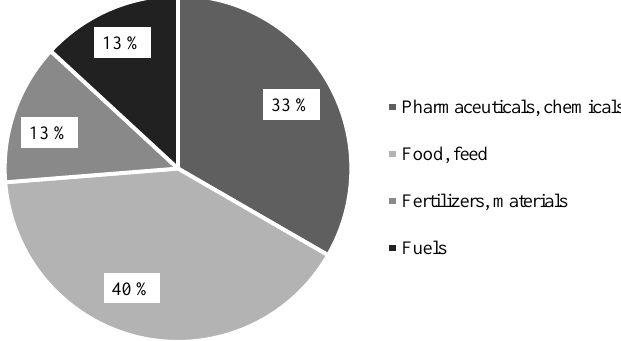
Fig. 5. Classification of the studied products by added